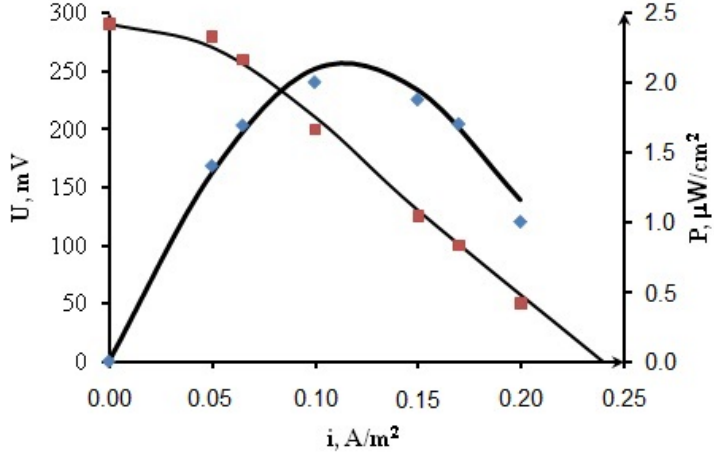
Figure 8. Current–voltage potentiodynamic curves and dependences of power density on current density for MFC CoFe/CNT + BM.